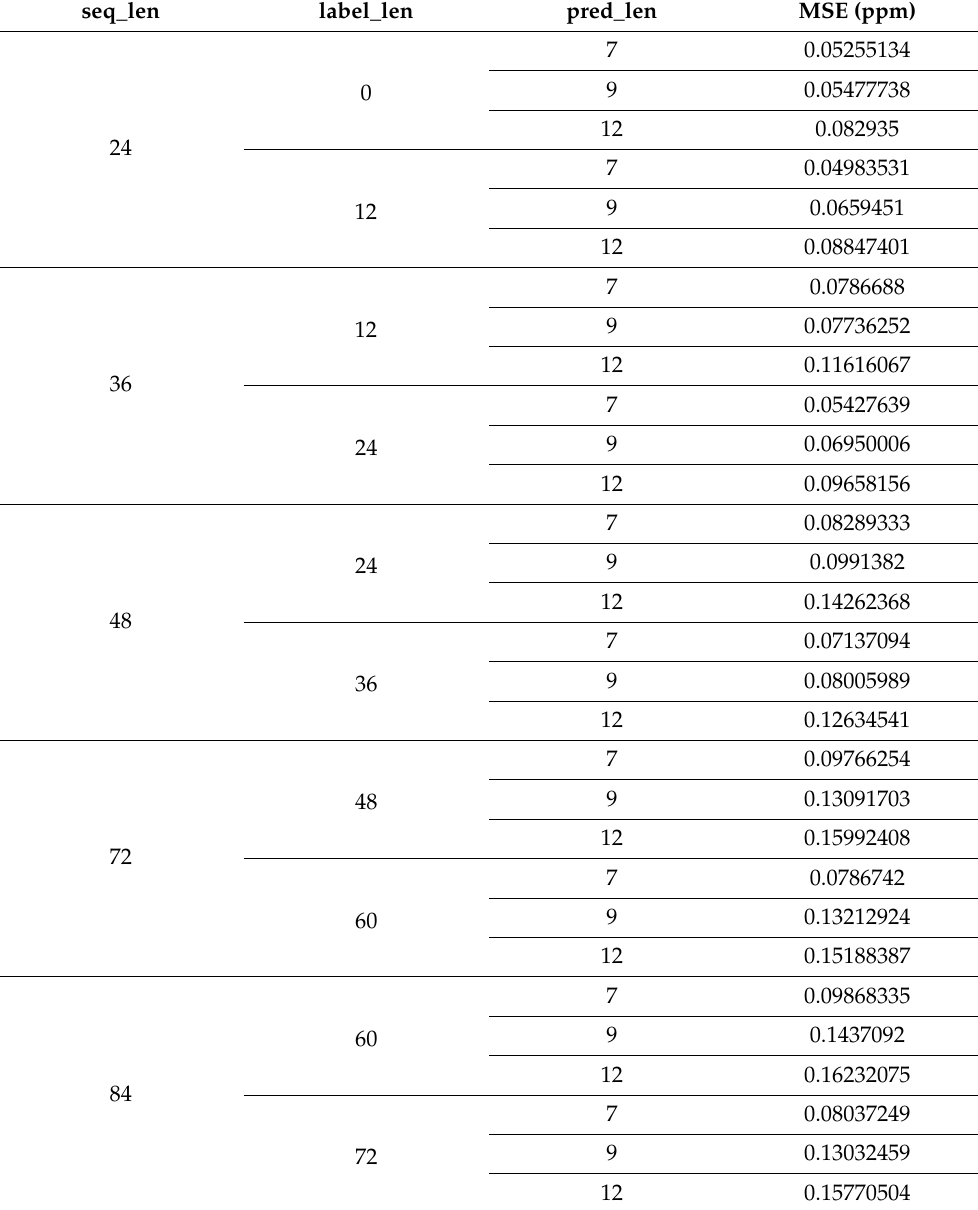
Table 5. Effect of model parameters on prediction accuracy of the